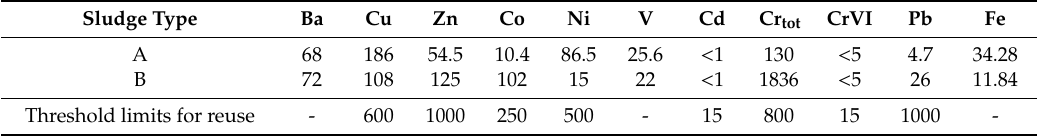
Table 4. Chemical composition of sawing sludge (threshold limits defined in [40], values in mg /